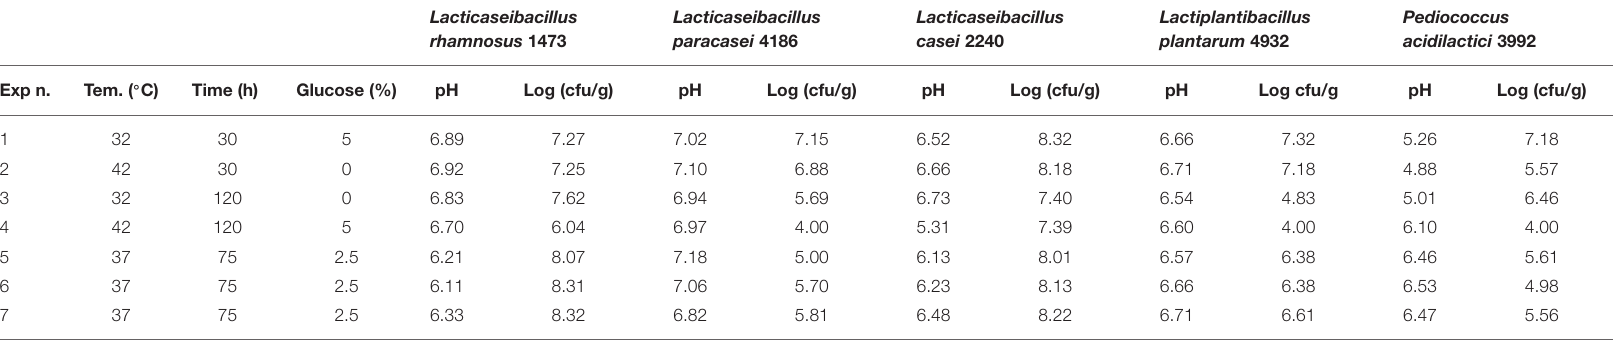
TABLE 4 | Experimental condition for strains with an optimum at 37 ◦ C in vanilla beans with seeds.